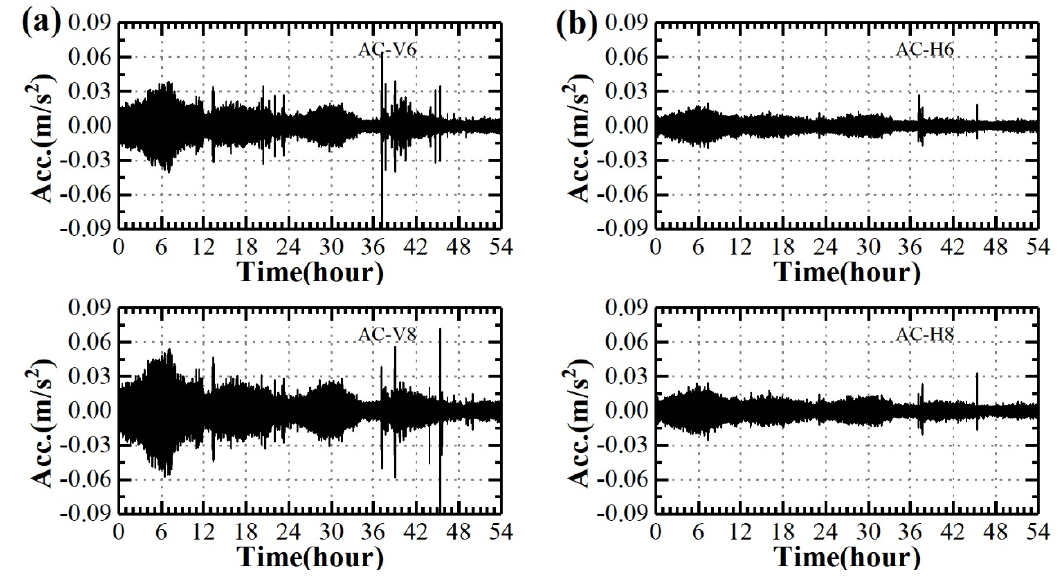
Figure 8. Wind spectra obtained via the field measurement: ( a ) Longitudinal velocity; ( b ) Lateral velocity; ( c ) Vertical